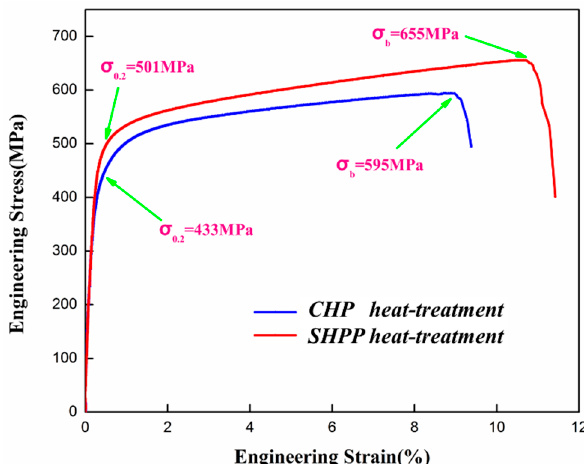
Figure 5. Engineering stress-strain curve of CHP steel (blue curve) and SHPP steel (red curve).